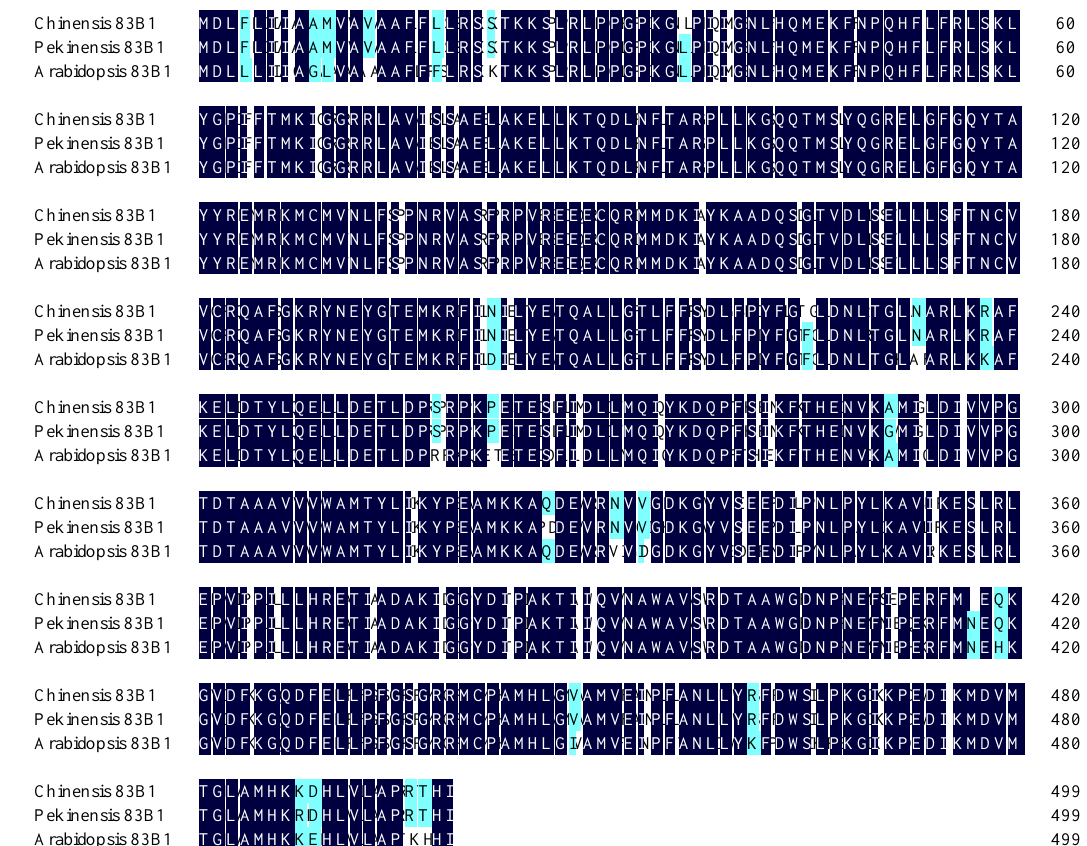
Figure 2. Multiple alignment of deduced amino acid sequences of CYP83B1 . Black shaded and other shaded boxes show identical and similar amino acids, respectively.